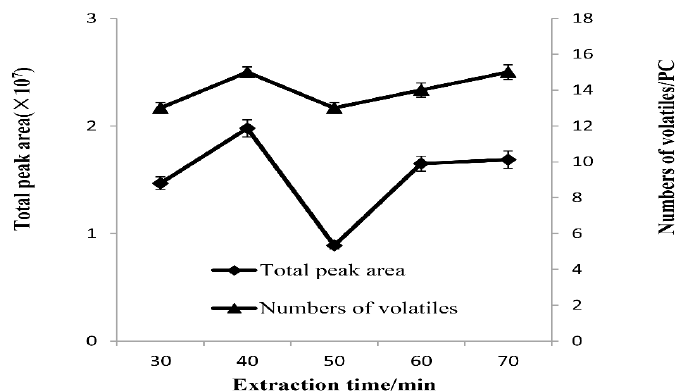
Figure 5. Effect of extraction time on total peak area and numbers of volatiles from stink tofu brine.